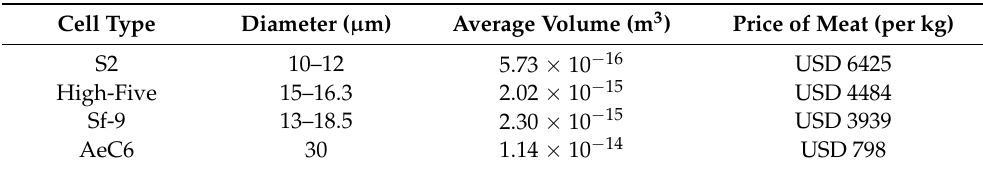
Table 9. List of cell types with range of reported cell diameters from the literature, average cell volumes, and corresponding prices of meat per kilogram.